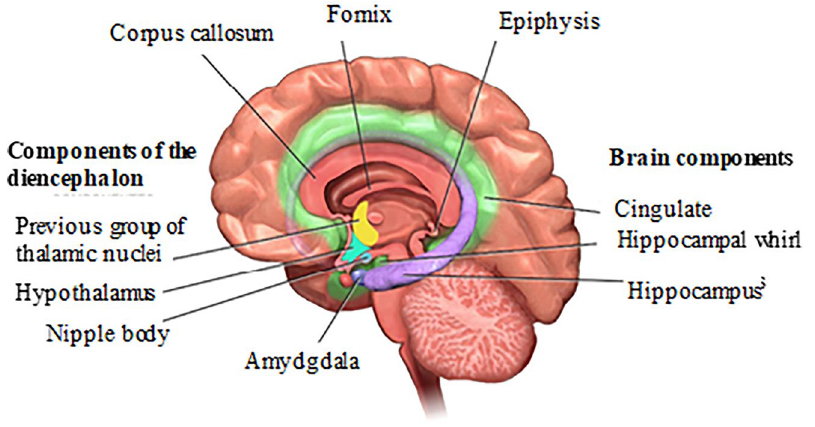
Figure 6. Anatomical view of the brain limbic system 43